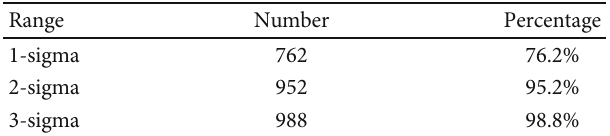
Table 7: Con fi dence interval for Monte Carlo simulation in the Earth